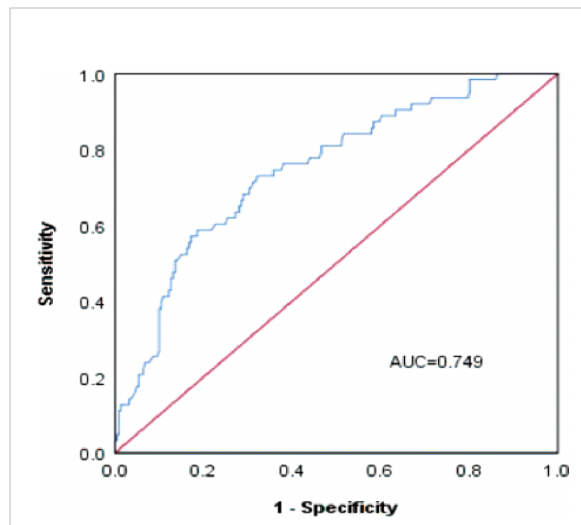
FIGURE 6 ROC curve of the risk prediction model for the prediction of bile duct injuries after DEB-TACE in patients with